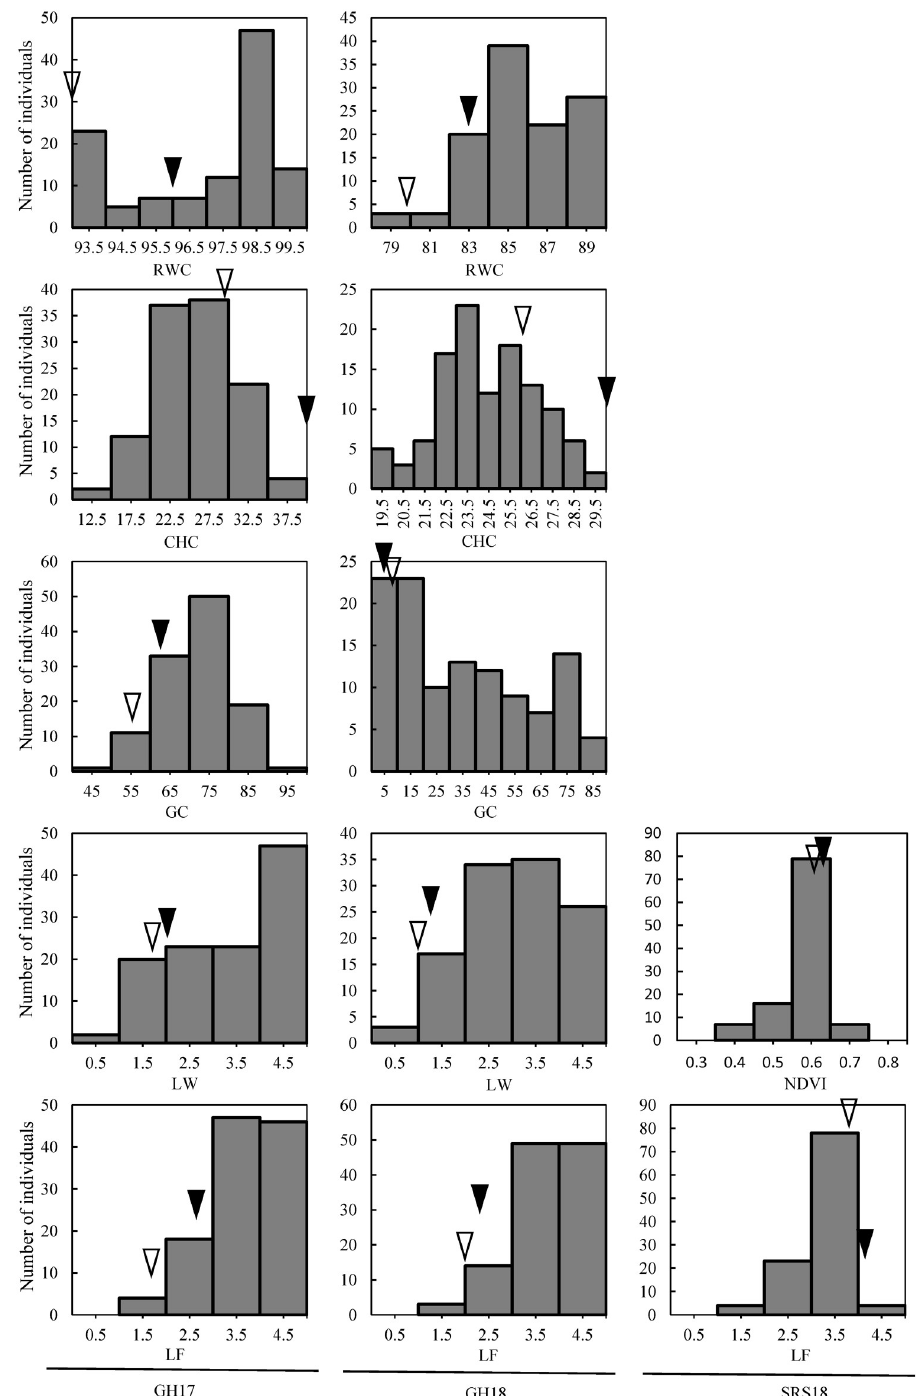
Fig 2. Distribution of chlorophyll content (CHC), percent green cover (GC), leaf relative water content (RWC), leaf wilting (LW), leaf firing (LF) and normalized difference vegetation index (NDVI) values for a St. Augustinegrass Raleigh x Seville F1 population evaluated for drought response under greenhouse (GH17 and GH18) and field conditions (SRS18). Solid triangle indicates Raleigh and white triangle indicates Seville.